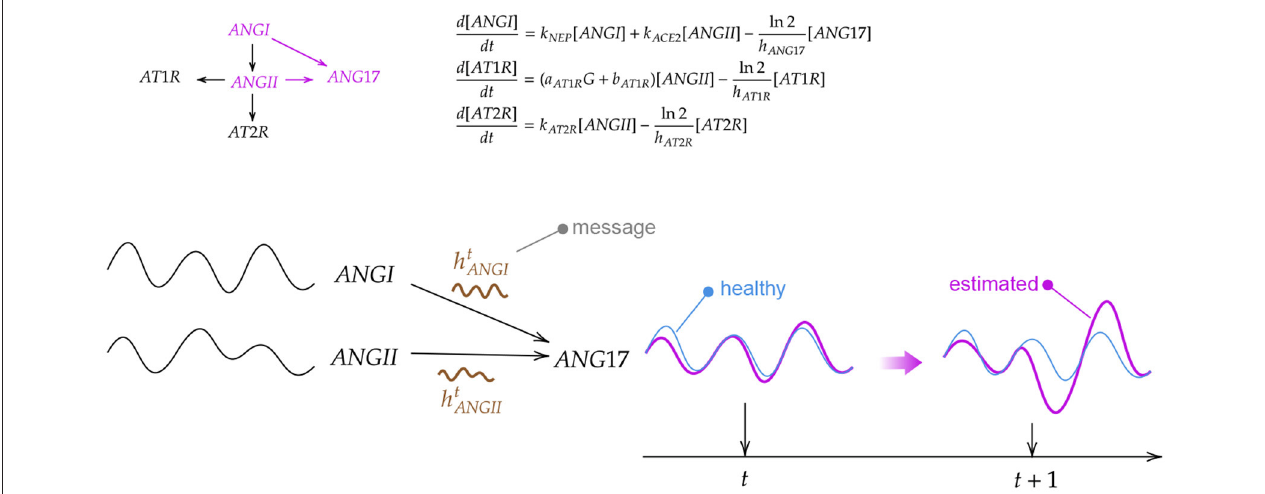
FIGURE 4 | Example of how a biological system can be modeled in a graph neural network through differential equations. First, an ordinary differential equation (ODE) system is derived from a biochemical reaction network. Then, the ODE system is solved for different initial conditions generating a set of trajectories for each variable. Finally, a graph neural network aggregates the information coming from neighbor nodes to update the current state of the